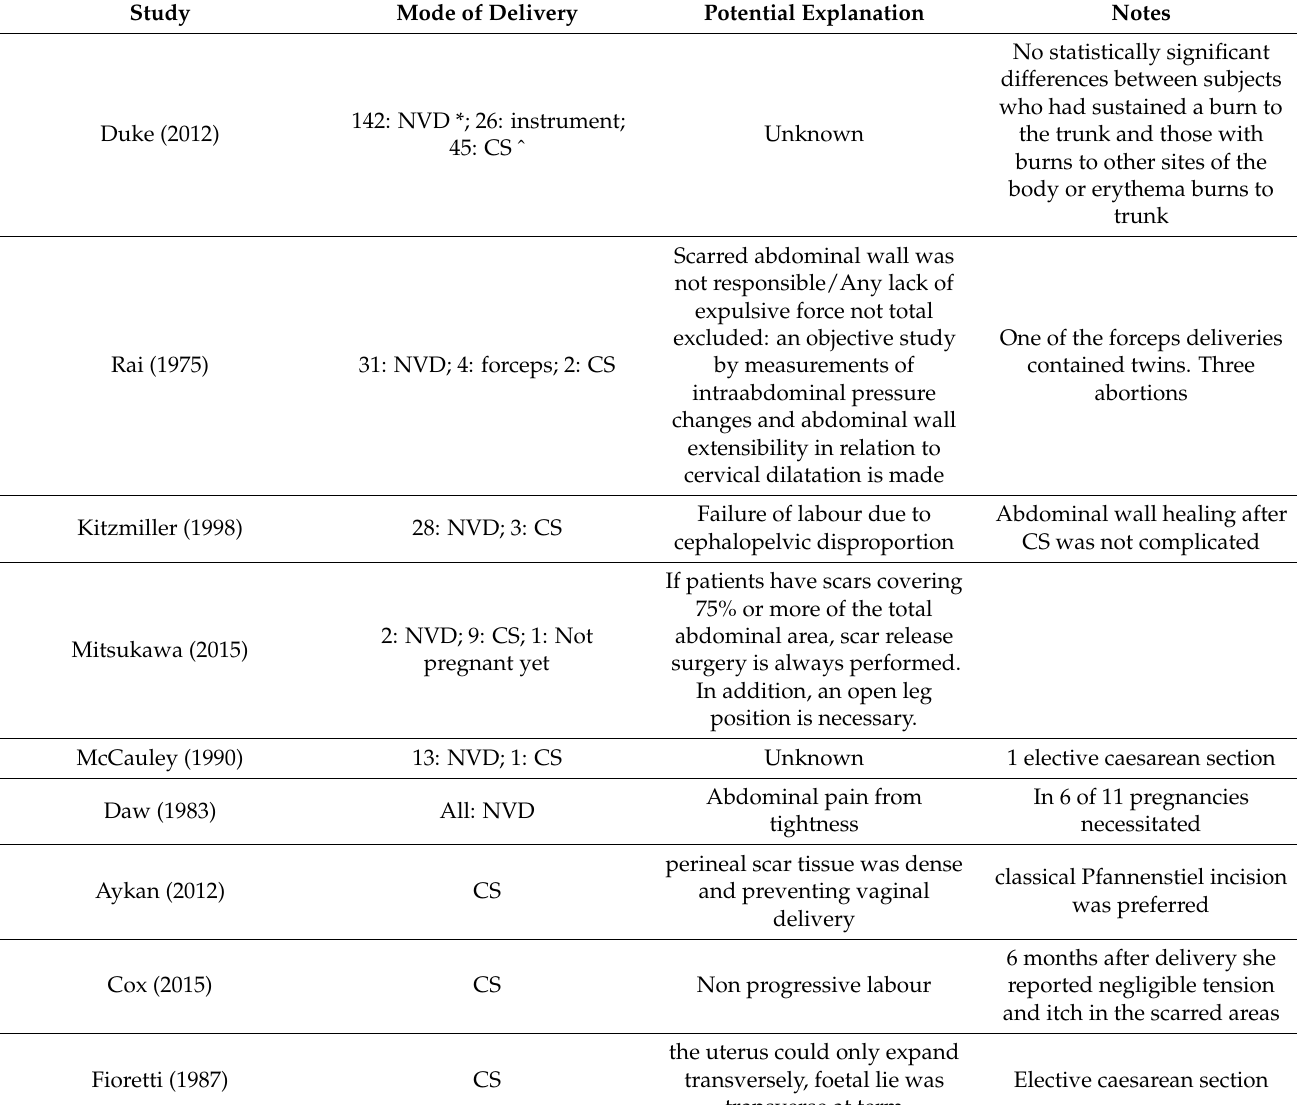
Table 5. Mode of